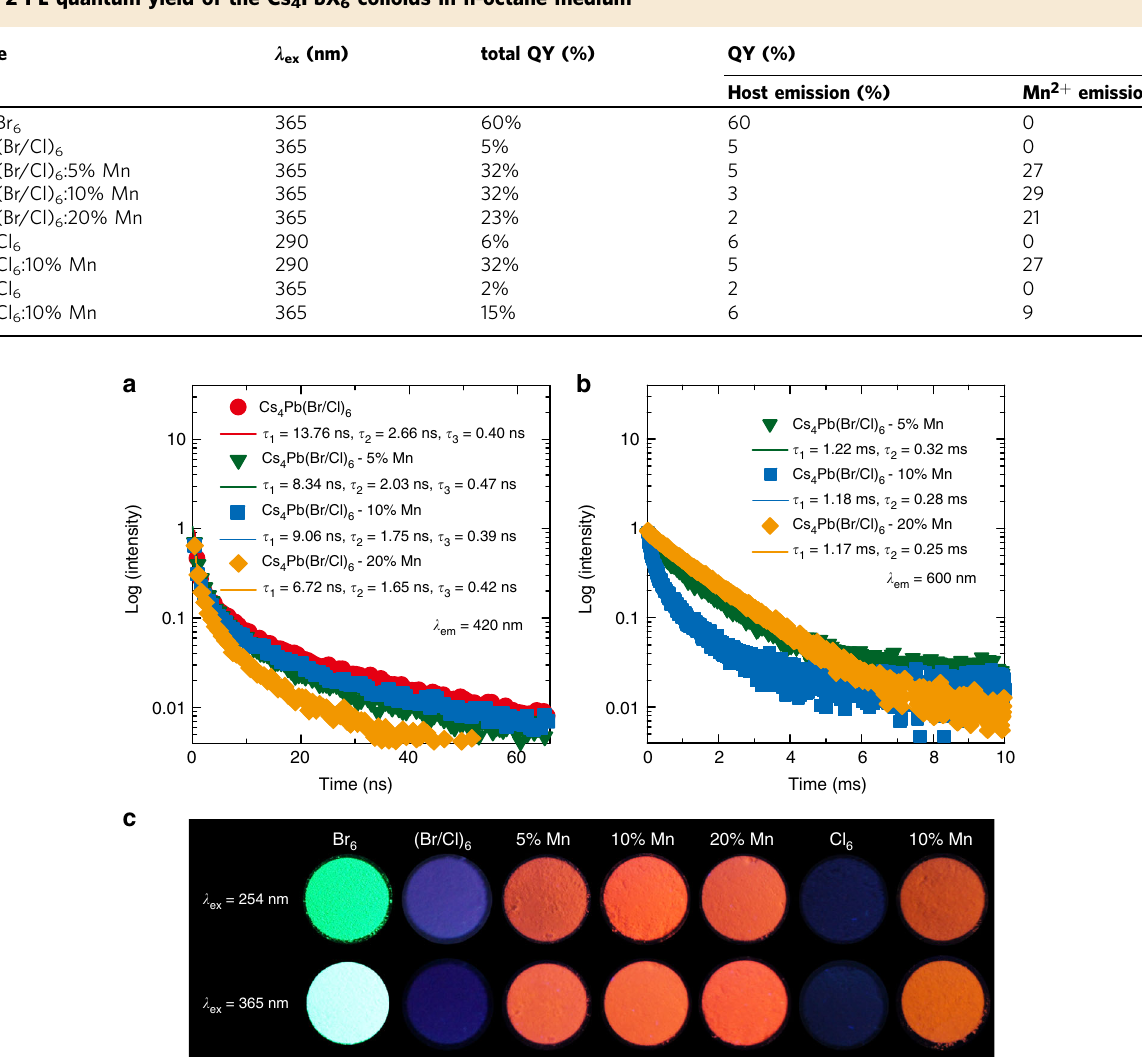
Fig. 4 Lifetime of Mn 2 + -doped Cs 4 PbX 6 . Time-resolved PL spectra of Cs 4 Pb(Br/Cl) 6 colloids excited at 375 nm and monitoring the D-state and Mn 2 + emission at a 420 and b 600 nm, respectively. c Images of Cs 4 PbX 6 perovskite solids under 254 and 365 nm UV lamp, which are denoted by their respective halides and Mn